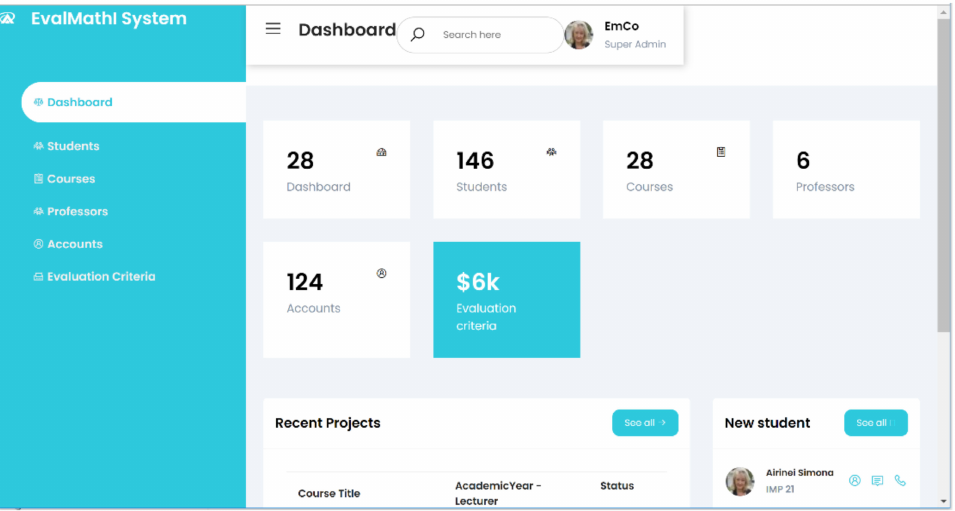
Figure 3. EvalMathI system admin panel and main